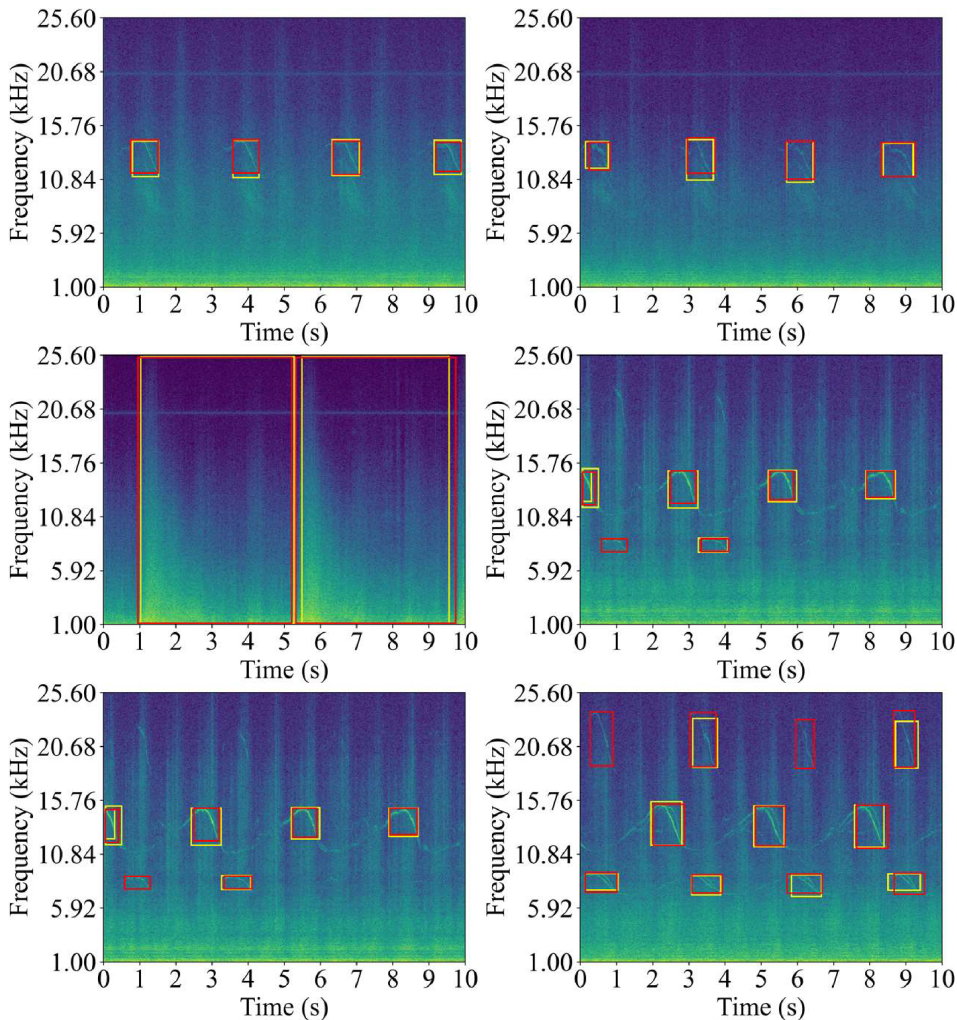
Figure 9. Examples of object detection results on the spectrograms using the Faster R-CNN based on WTBMobileNet. The red is the ground-truth box, and the yellow is the predicted